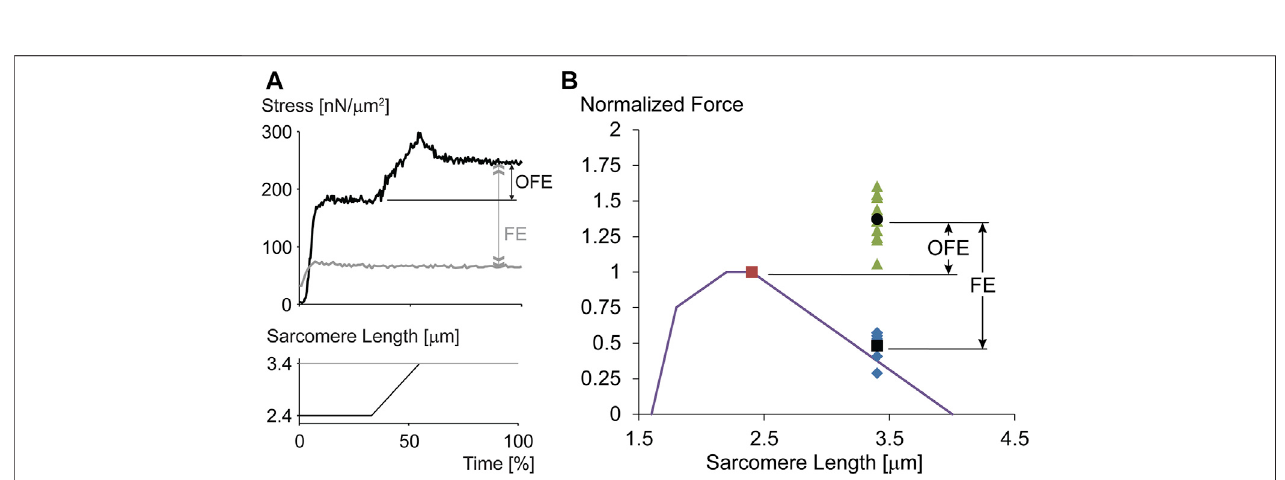
FIGURE 4 | (A) Force-time and sarcomere length-time trace for an exemplar experiment performed on a single, mechanically isolated sarcomere. The isometric referencecontractionat asarcomere length of3.4 µm isshown in gray,and thecorrespondingforce enhancement test (stretch from asarcomerelengthof2.4 – 3.4 µm) is shown in black. Note that the initial isometric contraction for the force enhancement test (black trace) was performed at optimal sarcomere length for the rabbit psoas sarcomere used here. Observe the dramatic force enhancement, FE (greater than 200% in this example), and the substantial force above the maximal isometric force at optimal length (OFE). (B) Theoretical sarcomere force-length relationship for rabbit skeletal muscle and isometric reference force obtained at optimal sarcomere length (red dot, normalized to 1.0), the corresponding isometric reference forces obtained at a sarcomere length of 3.4 µm, and the corresponding isometric, steady state forces obtained after stretching single sarcomeres from 2.4 to 3.4 µm while activated. The average force enhancement (FE; average values are indicated by the black dots) was 185% and the average enhanced forces exceeded the isometric optimal reference forces (OFE) by 38%. In summary, single mechanically isolated sarcomeresshowgreatresidualforceenhancementand exceeded theisometricreferencesforces atoptimal sarcomerelengthinallcaseswhenstretchedfromoptimal (2.4 µm) to the fi nal (3.4 µm) sarcomere length. Republished with permission of American Physiological Society, from Residual force enhancement following eccentric contractions: a new mechanism involving titin. Herzog W., Schappacher Tilp G, DuVall M, Leonard TR, Herzog J. Physiology 31: 300 – 312. 2016; permission conveyed through Copyright Clearance Center Inc.